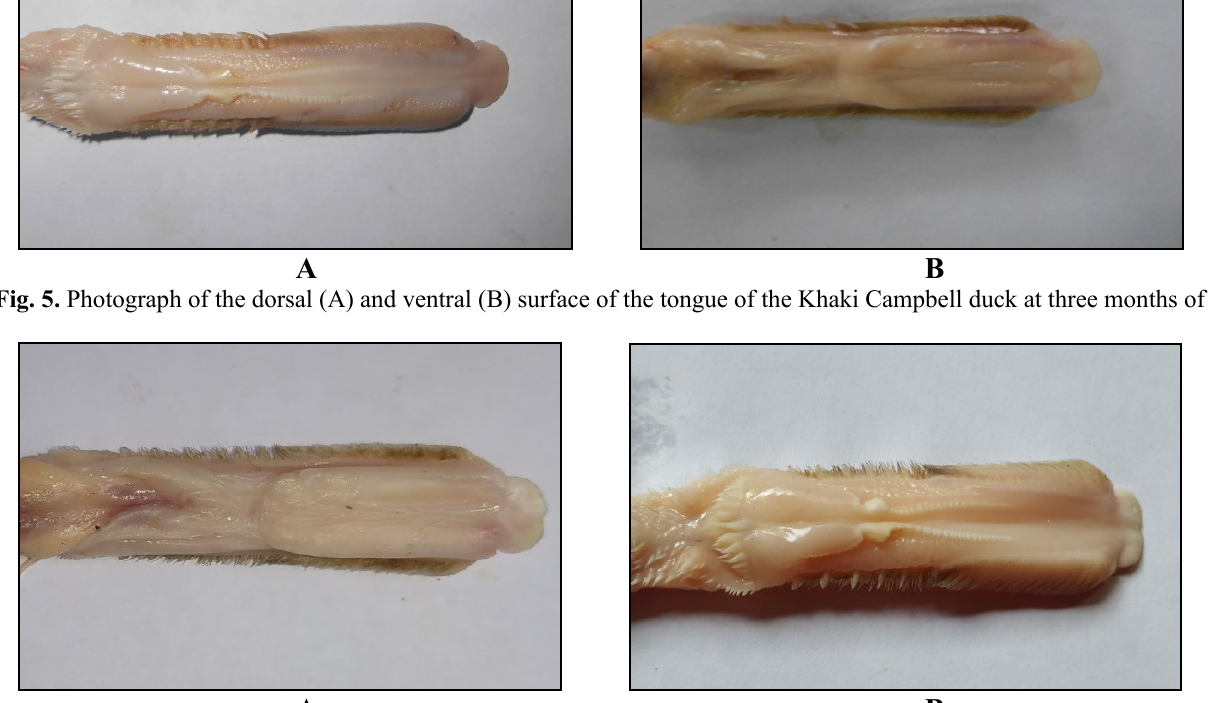
A B Fig. 6. Photograph of the dorsal (A) and ventral (B) surface of the tongue of the Khaki Campbell duck at four months of age The different parameters (mm) of the tongue ((Mean ± SEM)